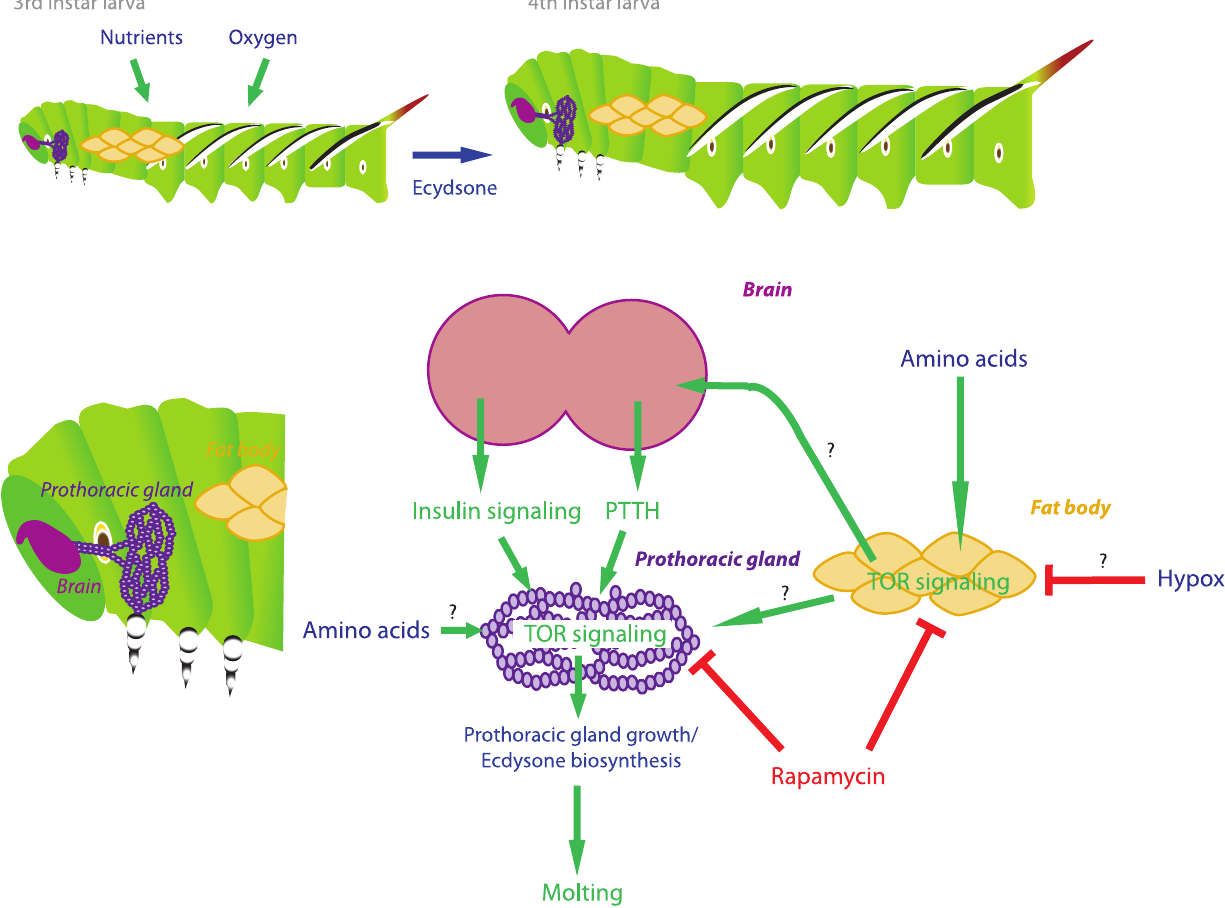
Figure 7. Model of how environmental cues might interact with TOR signaling to influence the timing of a molt.